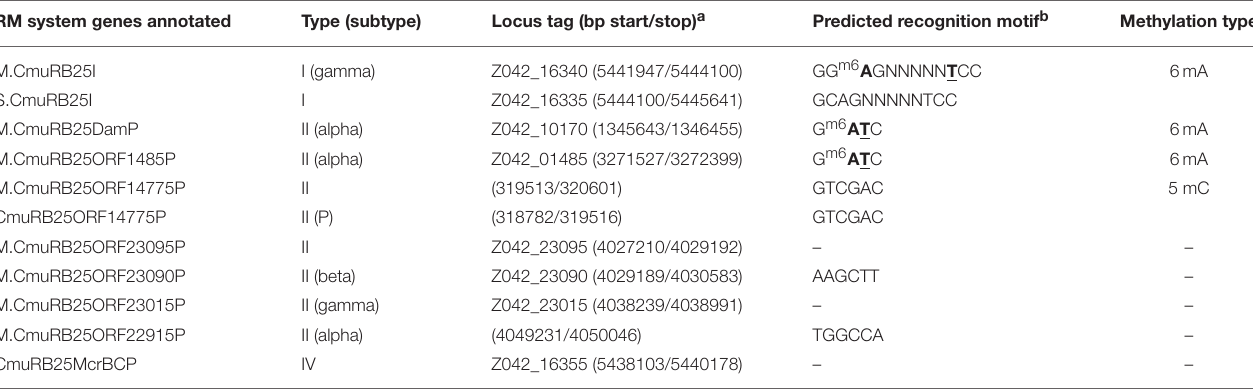
TABLE 1 | MTases and their predicted specificities identified in Chania multitudinisentens RB-25 T